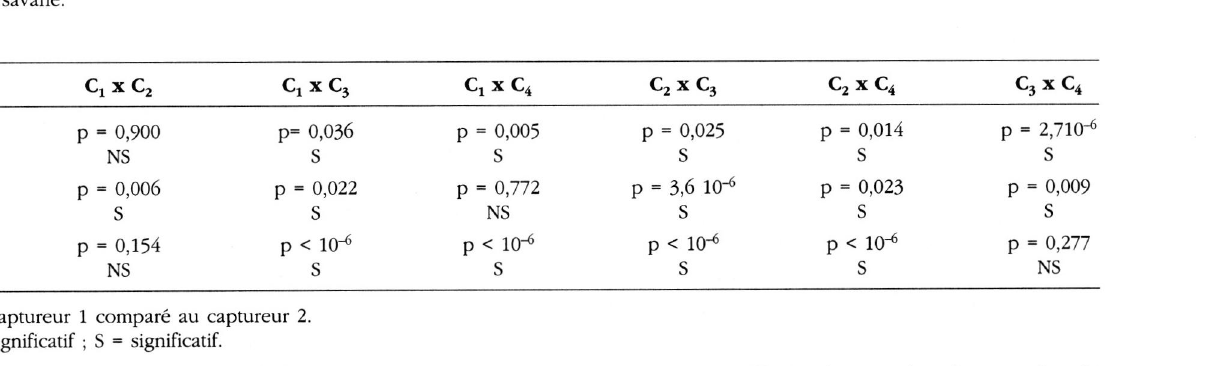
Tableau II. - Comparaison deux à deux de l'efficacité des formulations (lotions, crèmes) à base d'huiles de coco, de palmiste et de gobi selon le captureur en zone de